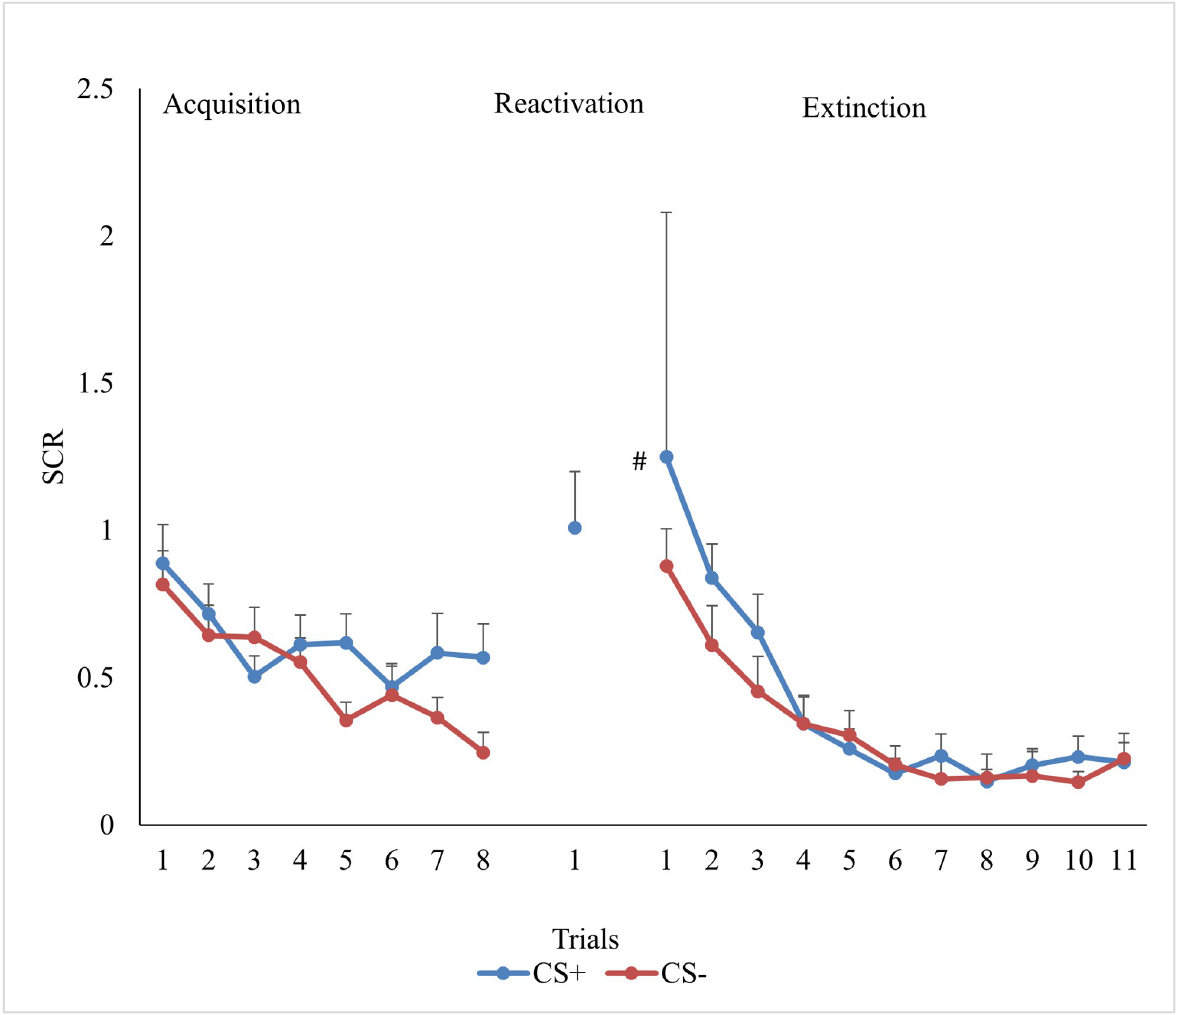
Fig 2. Mean SCR trial results for acquisition and extinction. Note . Mean skin conductance response (SCR) across trials collapsed across groups. Acquisition consisted of presentations of the CSa+ that was sometimes paired with the US and the CS- that was never paired with the US. Extinction consisted of the presentation of the CSa+ and the CS- without the US. Measures of SCR were taken at every presentation of a stimuli. � EDA for groups that received reactivation. # EDA for the first trial of the CS+ for the group that did not receive reactivation.